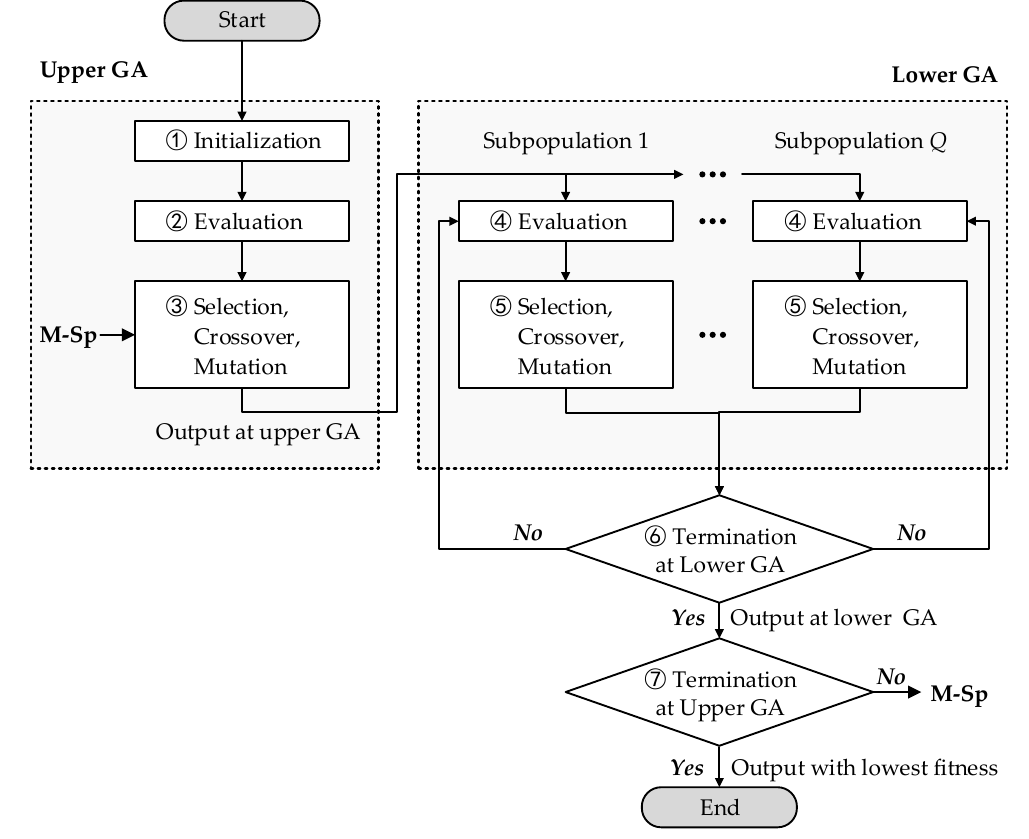
Figure 4. The flowchart of the improved genetic algorithm.